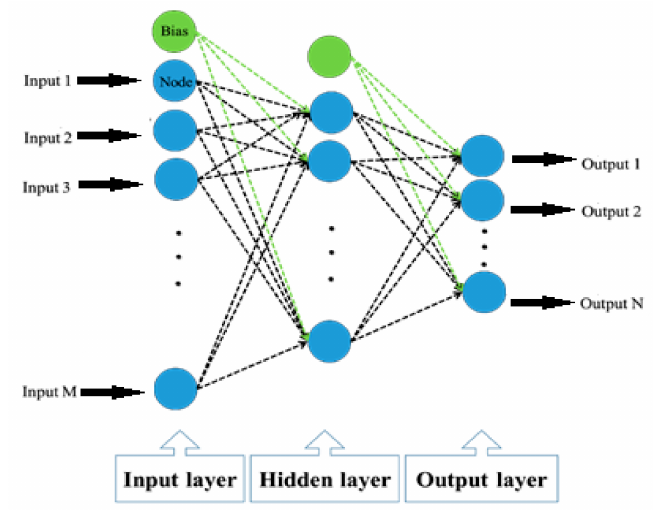
Figure 1. A three-layer multi-layer perceptron